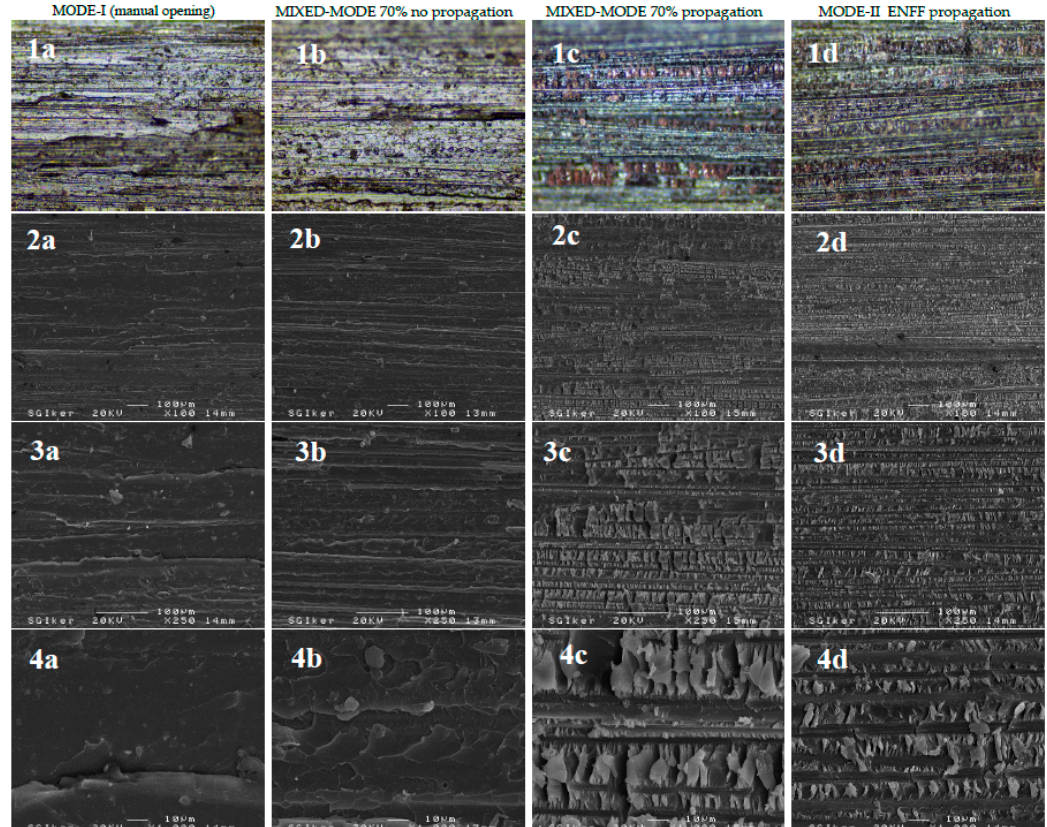
Figure 13. Optical and SEM micrographs. First row: optical ×10, Second row: SEM ×100, Third row SEM ×250 Forth row SEM ×1000. ( a ) Mode-I, manual opening ( b ) Mixed-mode tests without propagation ( c ) Mixed-mode tests with crack propagation ( d ) Mode-II test with crack propagation.